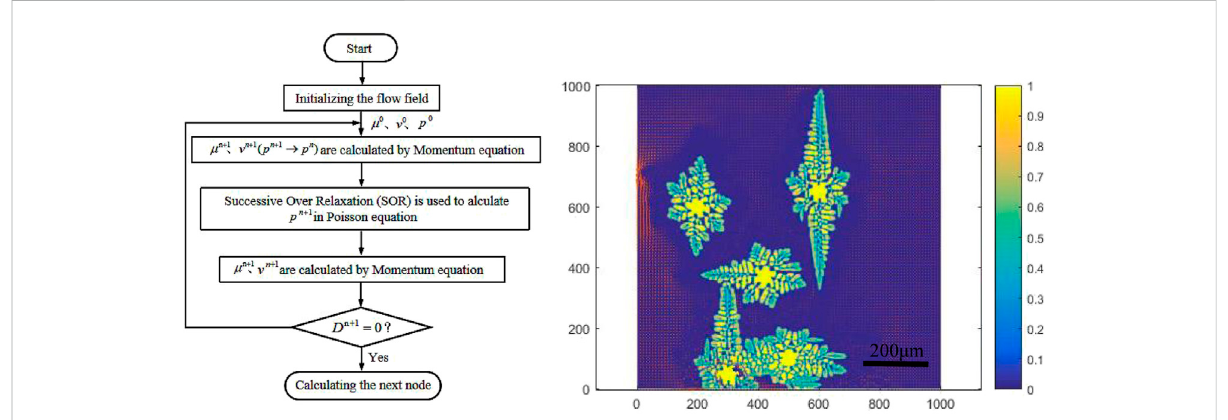
The iterative fl ow and simulation results of multi-crystal phase fi eld in the center of roll casting melt pool.